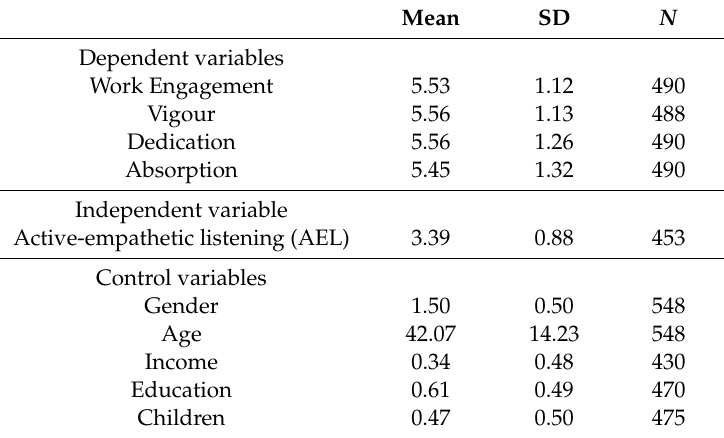
Table 1. Descriptive statistics.